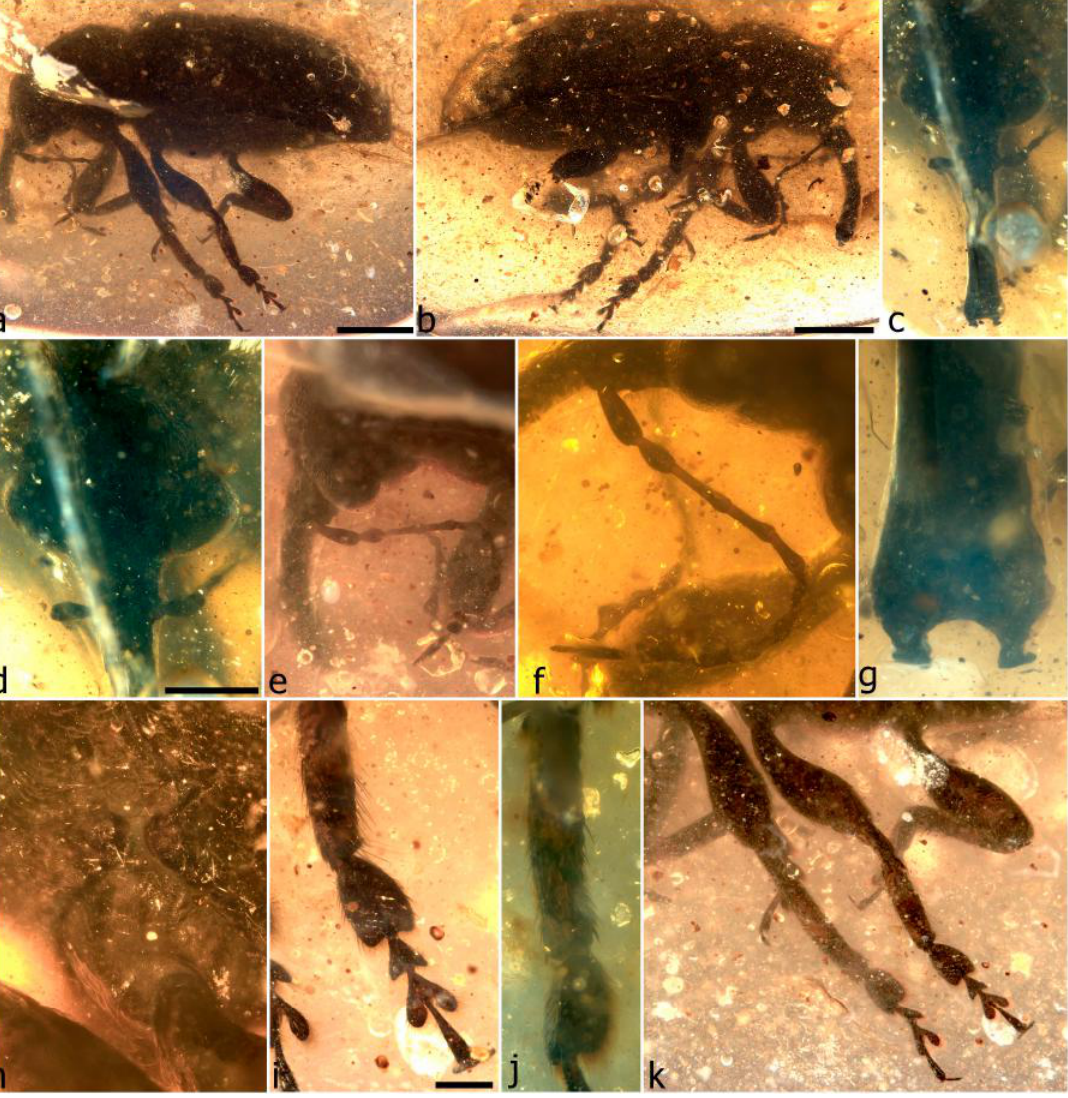
Figure 16. Platychirus beloides sp. n., holotype. Habitus, left lateral ( a ); habitus, right lateral ( b ); head, dorsal ( c ); eyes, dorsal ( d ); head and antenna, left lateral ( e ); detail of antenna and eyes, left lateral ( f ); apex of rostrum and mandibles, dorsal ( g ); open mesocoxal cavities ( h ); left mesotibiae, dorsal ( i ); left protibia, dorsal ( j ); left legs, dorsal ( k ). Scale bars: 1.0 mm (a,b); 0.5 mm (d); 0.2 mm (i).